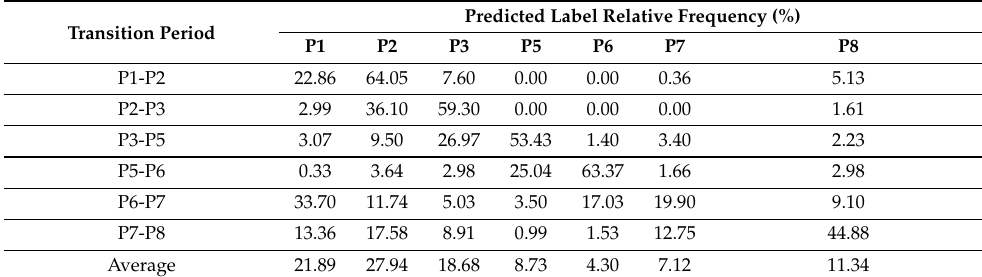
Table 7. Predicted label relative frequency (%) in each transition period, for the k-NN model with 3000